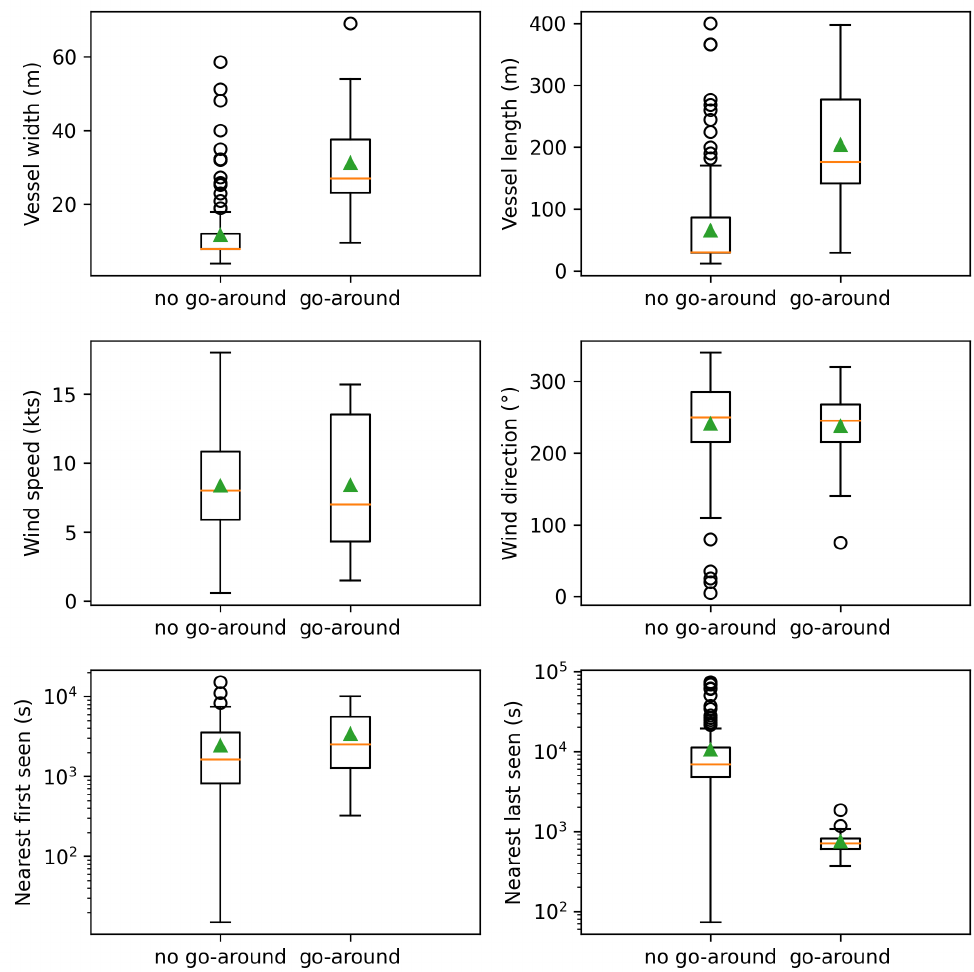
Figure 4. Comparison of largest passing vessel dimensions (top), weather conditions (center), and air traffic spacing (bottom) for each flight with (27) and without (172) go-around where vessel traffic was found. Orange line indicates median, green triangle indicates